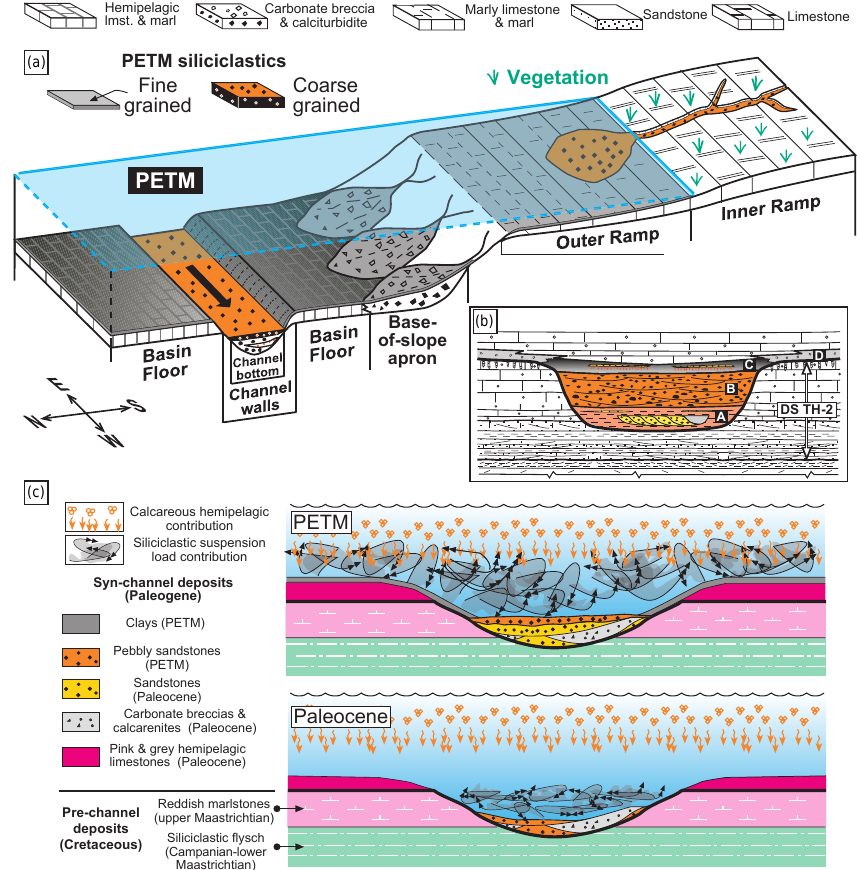
Figure 12. Panel (a) : reconstructed S–N transects of the southwestern margin of Pyrenean Gulf for PETM times: most of the gulf floor was mantled with fine-grained siliciclastics; however, coarse-grained sands and pebbly sands were also accumulated within incised valleys, deltas and a deep-sea channel. Panel (b) : reconstructed architecture of the incised valleys. Panel (c) : graphic models depicting the depositional conditions in the Basque Basin: throughout Paleocene times clastic loads were largely confined to the deep-sea channel, while hemipelagic deposition occurred on the basin floor. During the PETM clastic input increased dramatically: coarse-grained bed load remained confined to the deep-sea channel bottom but suspension load became widespread, blanketing the channel walls and diluting hemipelagic sedimentation on the basin